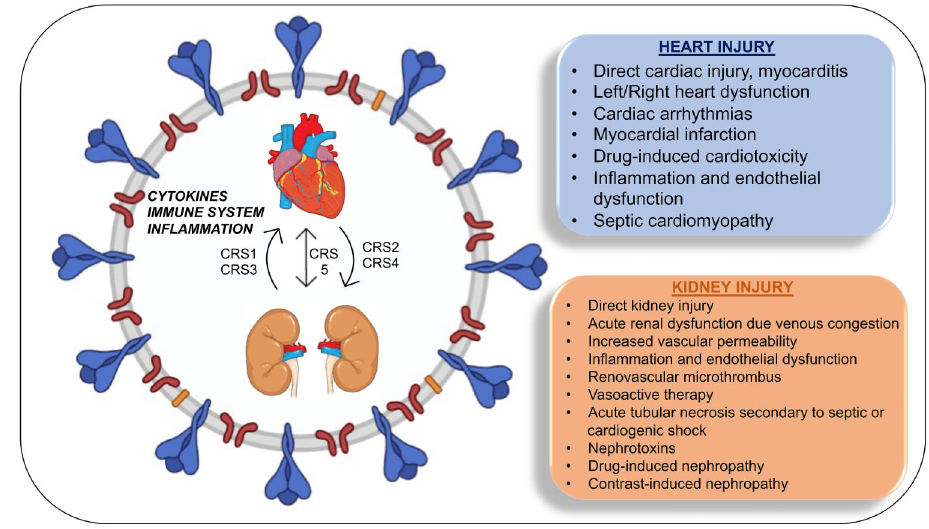
Figure 2. Schematic representation of COVID-19 pathophysiology and its effects on kidney and heart. CRS: cardiorenal syndrome; CRS 1 to 5: types of